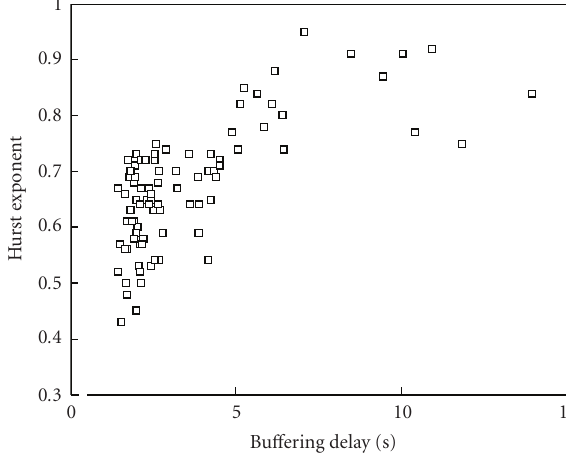
Figure 10: ACF of picture size in “The Living Sea” video sequence encoded with FFMPEG VBR video rate controller. Figure 11: Hurst exponent versus bu